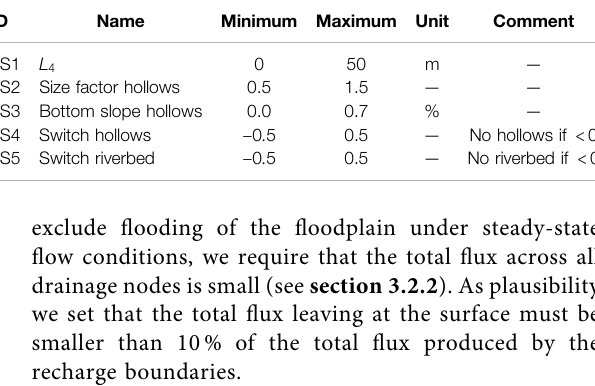
TABLE 3 | Prior ranges of structural parameters.